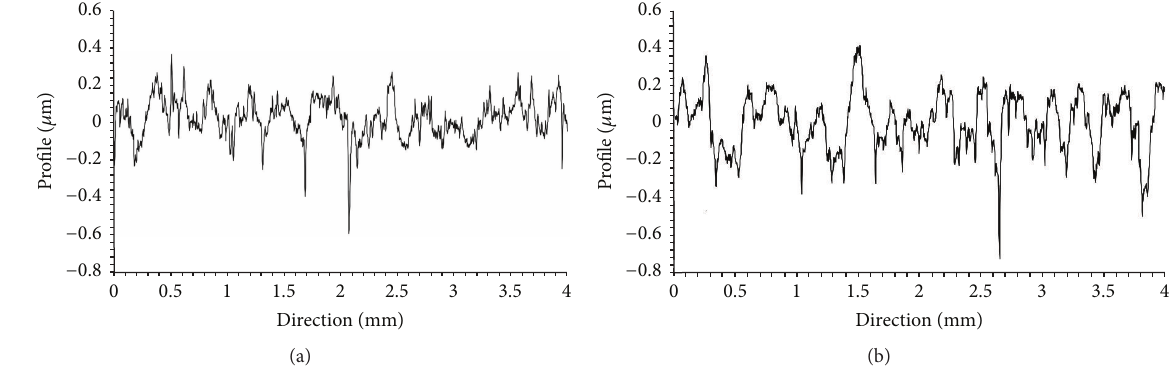
Figure 9: Typical roughness profiles in two different